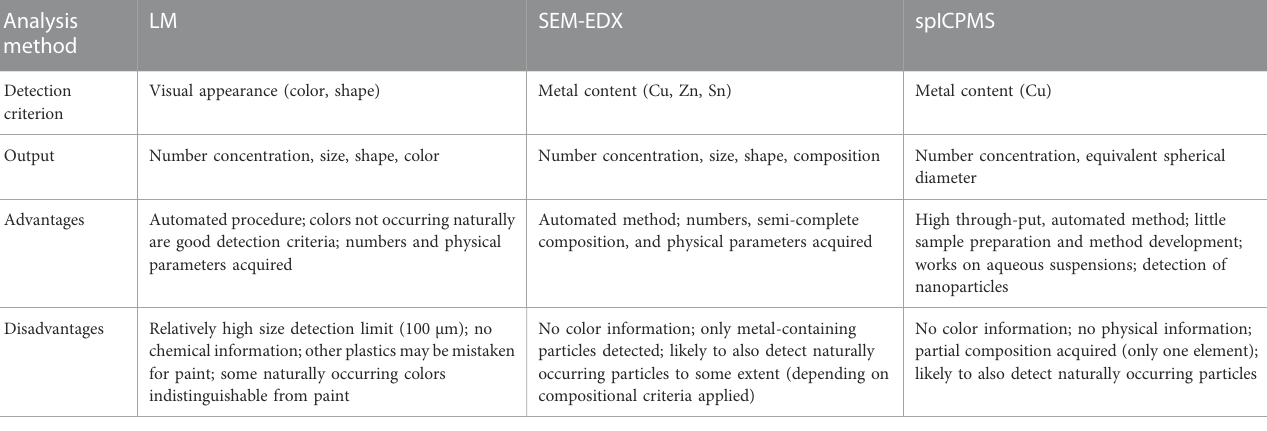
TABLE 2 Evaluation of the methods used in this study for analysis of boat paint